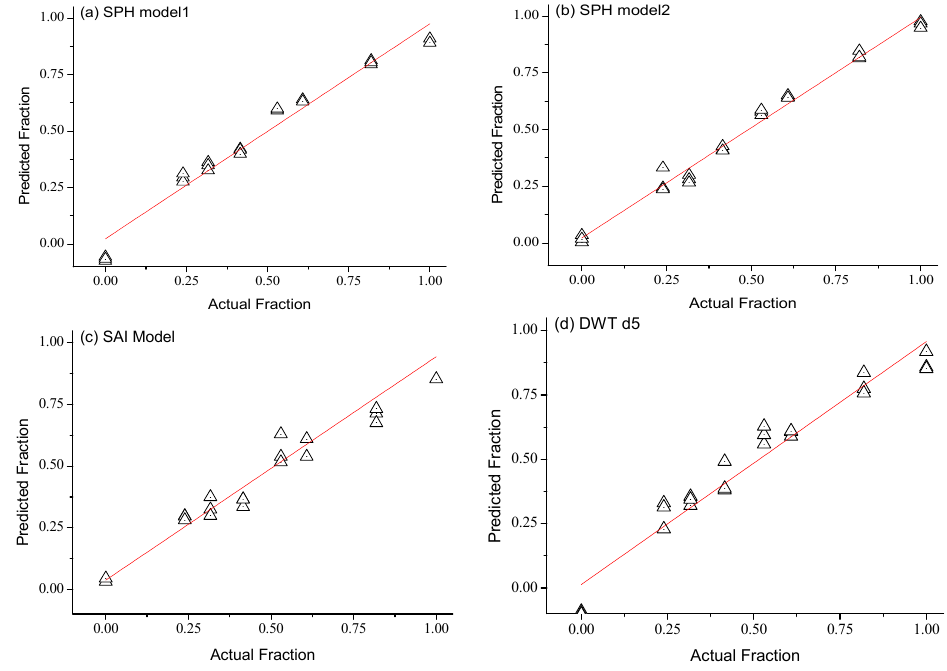
Figure 9. Validation of the models for predicting area fraction of oil on sea ice ranging from 0% to 100%. The adjusted R 2 values for SPH model1, SPH model2, SAI, and DWT d5 are 0.966, 0.986, 0.942, and 0.943, respectively, and the corresponding RMSEs are 0.003, 0.001, 0.005, and 0.005.